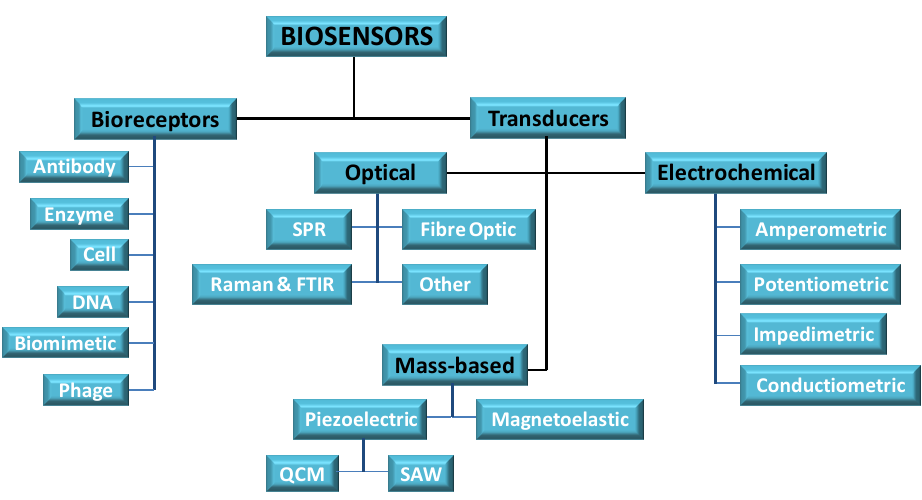
Figure 1. Components of a